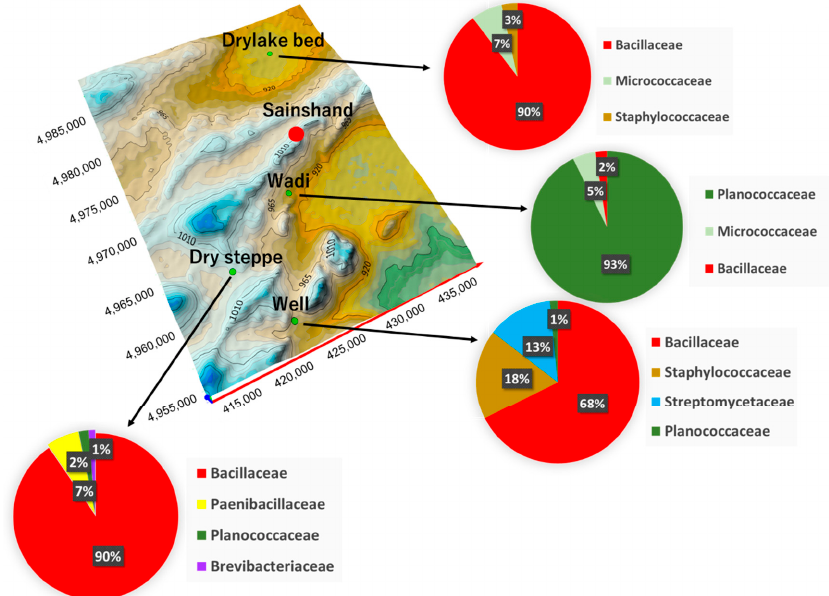
Figure 3. Geographical representation based on the family of bacteria isolated from surface soil. The pie chart shows the ratio of each land type for the identified family of bacteria. Similar distributions of bacteria have been confirmed in the dry lake bed and desert steppe, and various bacteria are distributed in the well. Wadi isolates are characterized by a different distribution of Planococcaceae than isolates from the other sample points. The background image is 3D topographic contours using SRTM data (Where, values on the vertical and horizontal axes indicate distances (m) on UTM (Universal Transverse Mercator) North 48 zone and the World Geodetic System (WGS) 84 projection).